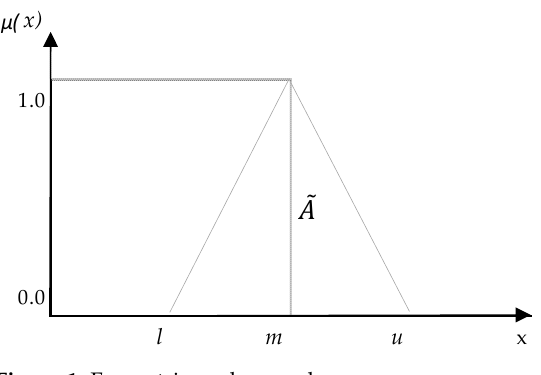
Figure 1. Fuzzy triangular number.